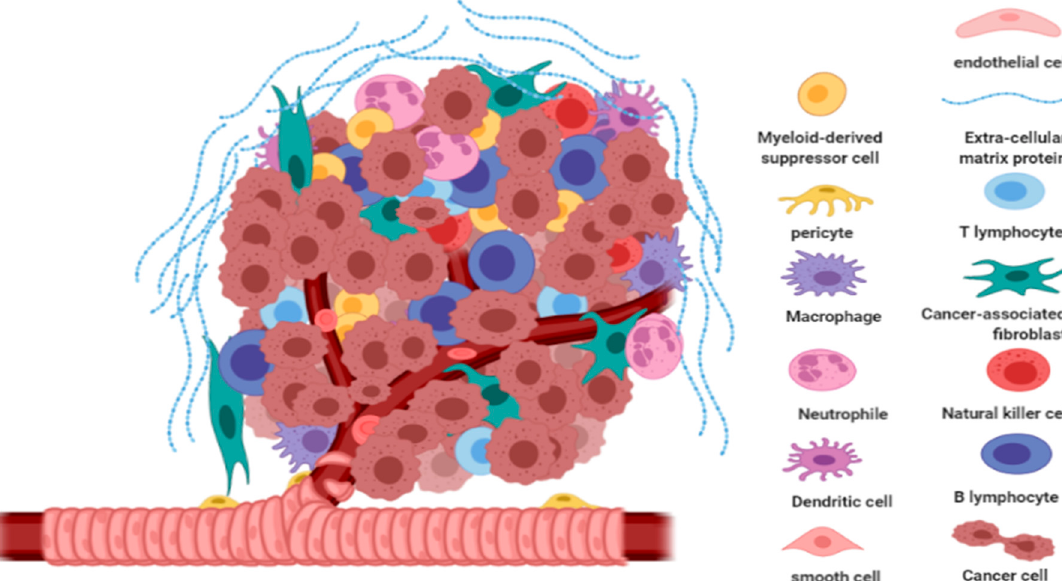
Figure 2. Tumor microenvironment. Various host cells and proteins work together to support cancer cell survival and progression. Created using Biorender software.